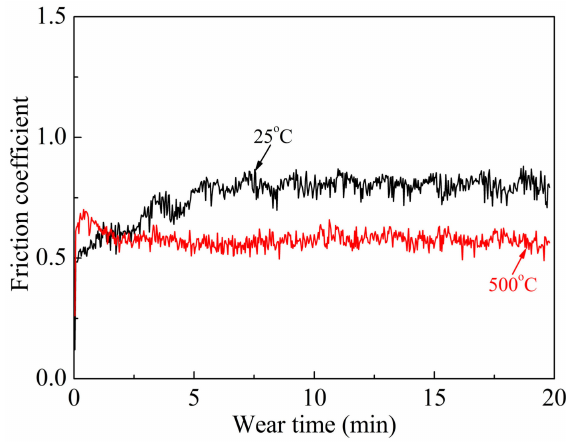
Figure 8. Friction coefficients of HEA/Ni60 coating at 25 ◦ C and 500 ◦ C.